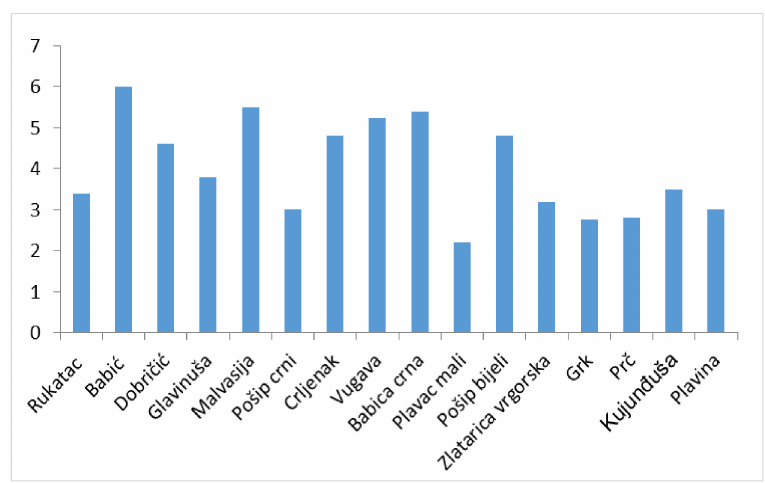
Figure 4. Average number of different viruses detected per grapevine